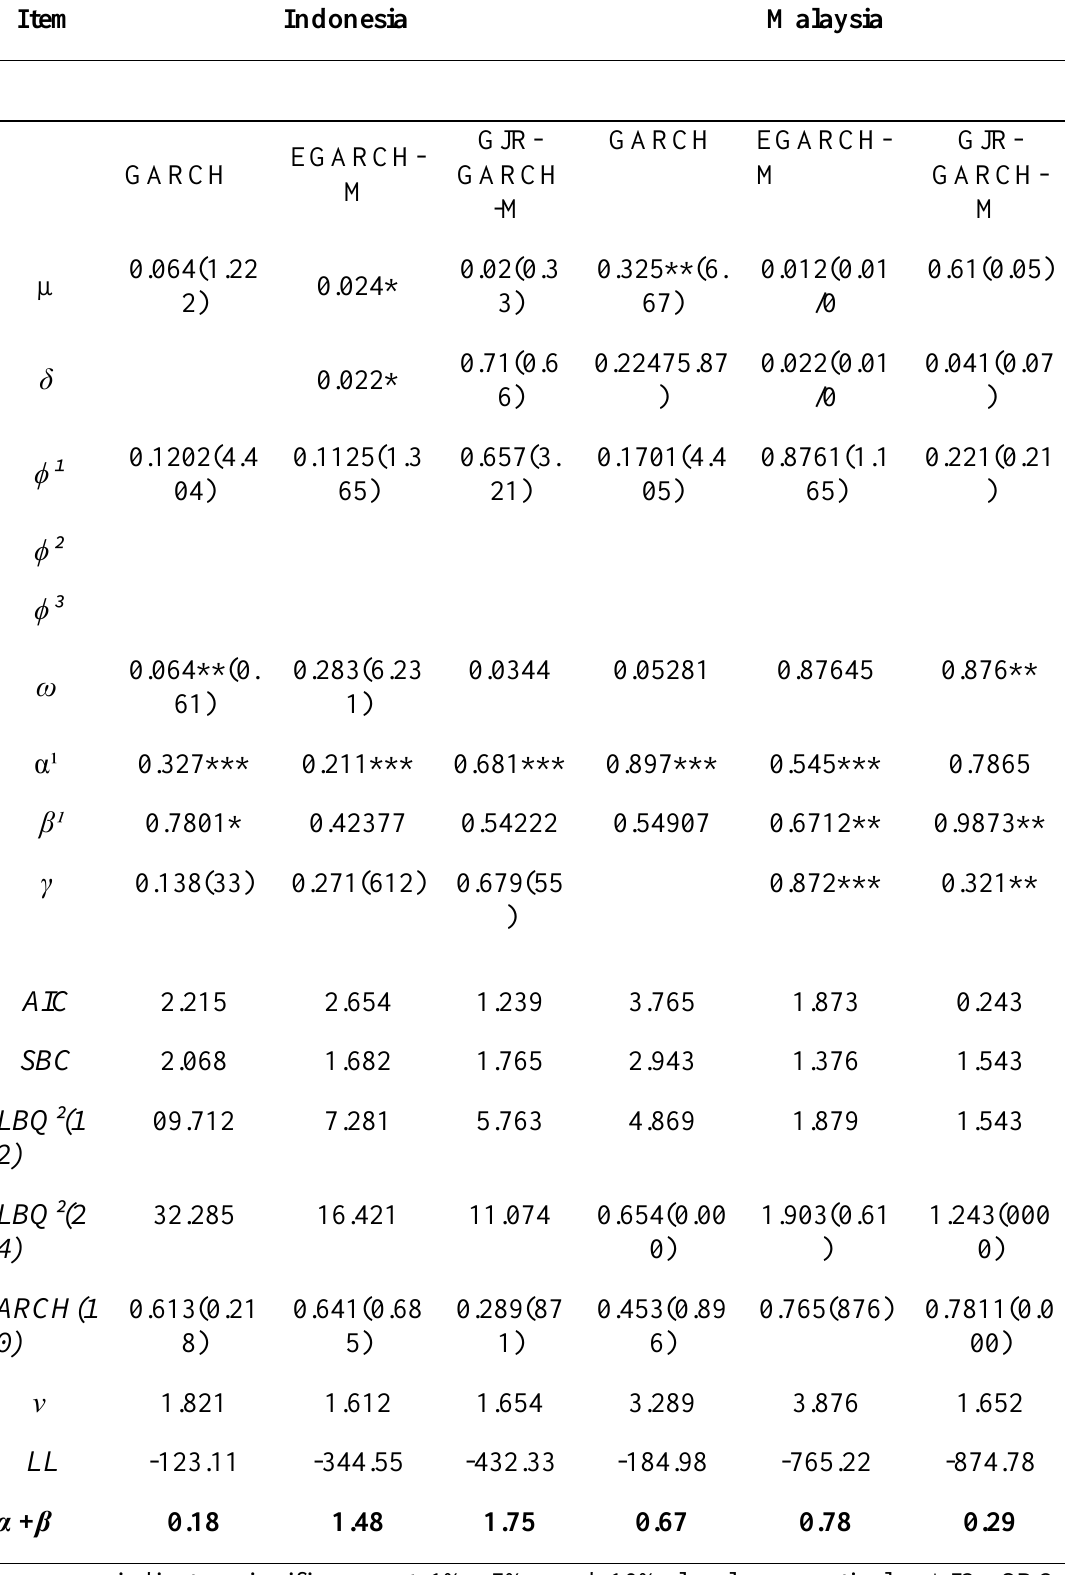
Table 6. Results of Fitting GARCH